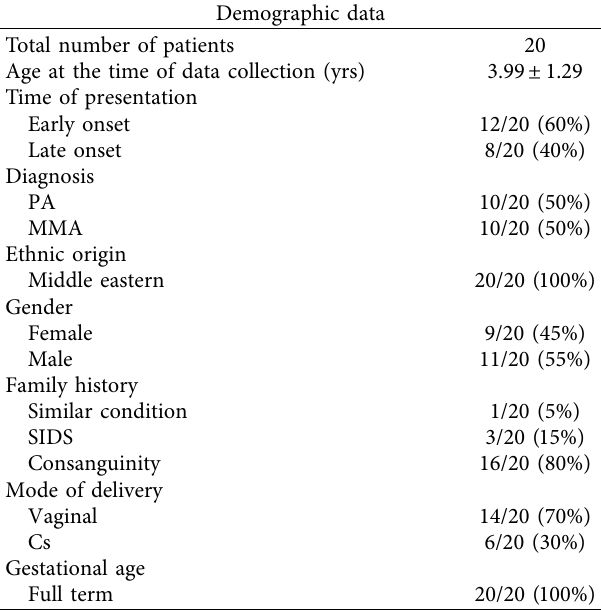
Table 1: Summary of the demographic data of the study group.